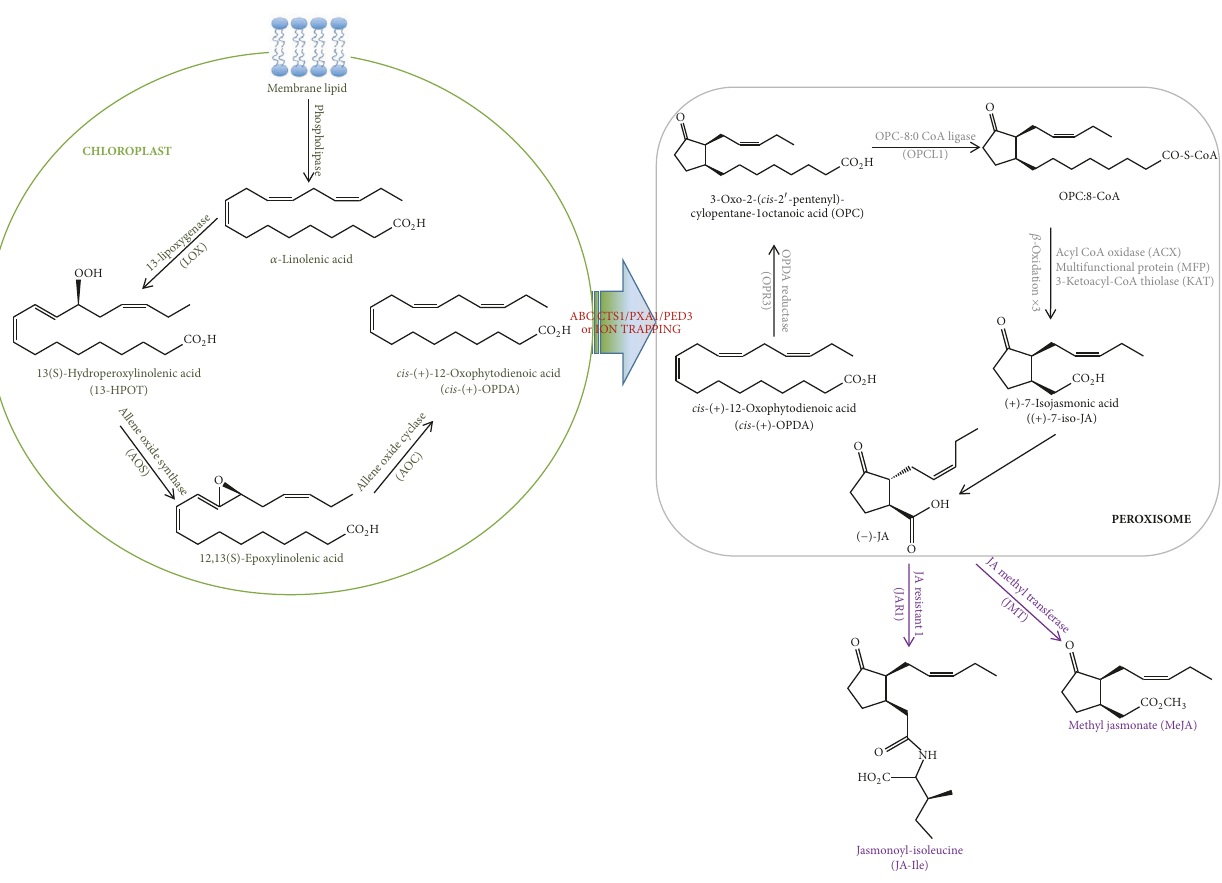
Figure 2: Biosynthetic pathway of jasmonates (JAs) [58, 71,